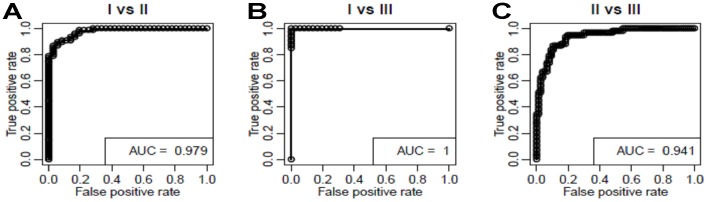
Classification of SMA types by the top 13 biomarker analytes Receiver-Operator curves. (ROCs) and (area under the curves (AUCs) were generated for the top 13 markers to differentiate between SMA types within the PNCRN’s natural history study dataset. Both sensitivity (True positive rate) and specificity (1-False positive rate) of the SMA type classifications were very high across several thresholds. A: Type 1 versus Type 2 AUC was 0.98. B: Type 1 versus Type 3 AUC was 1. C: Type 3 versus Type 3 AUC was 0.94.